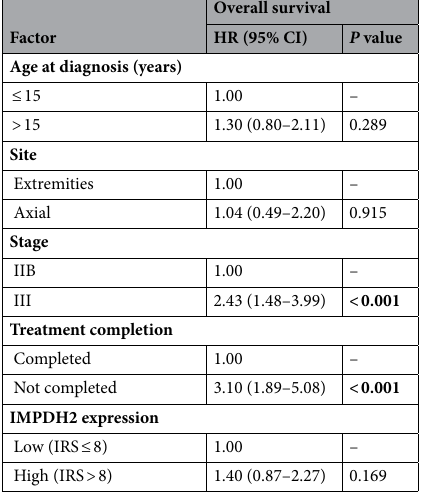
Overall survival HR (95%